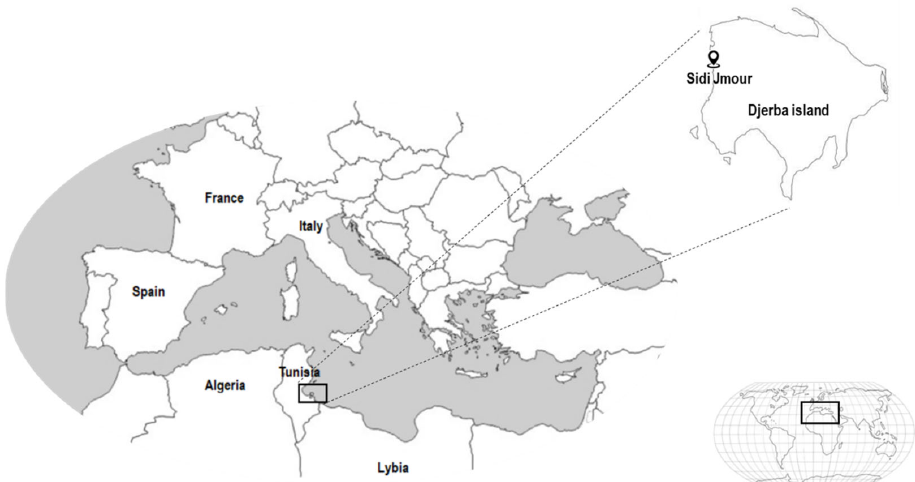
Figure 9. Location of the collection zone (the coastal area of Sidi Jmour, Djerba,